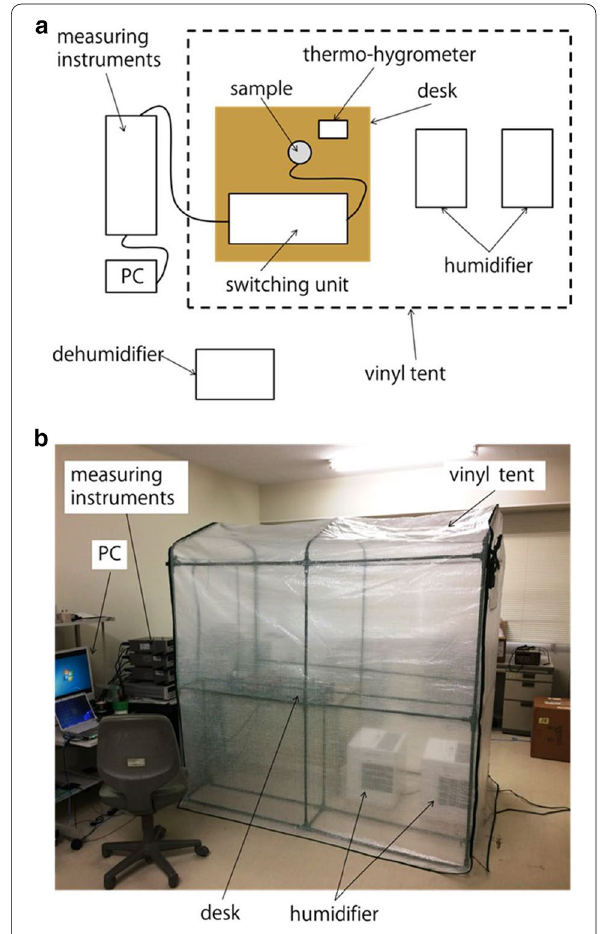
Fig. 3 a Layout of measurement instrumentation and b photograph of the measurement system in the